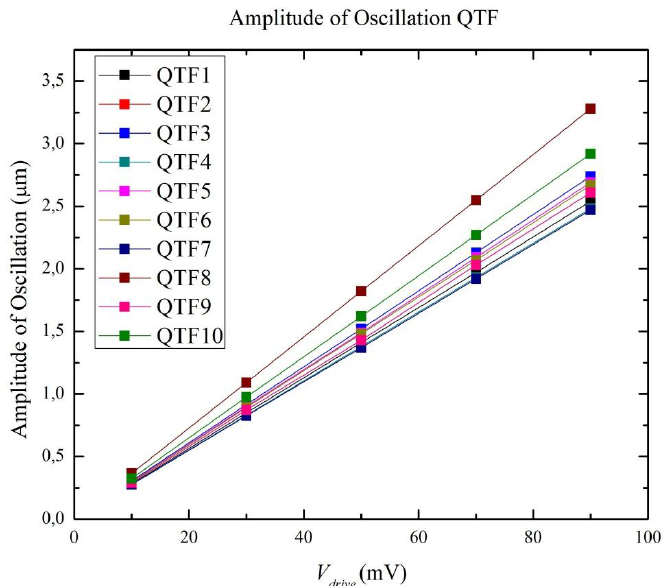
Figure 6. Results of the amplitude of oscillation of the ten QTFs from the finite element